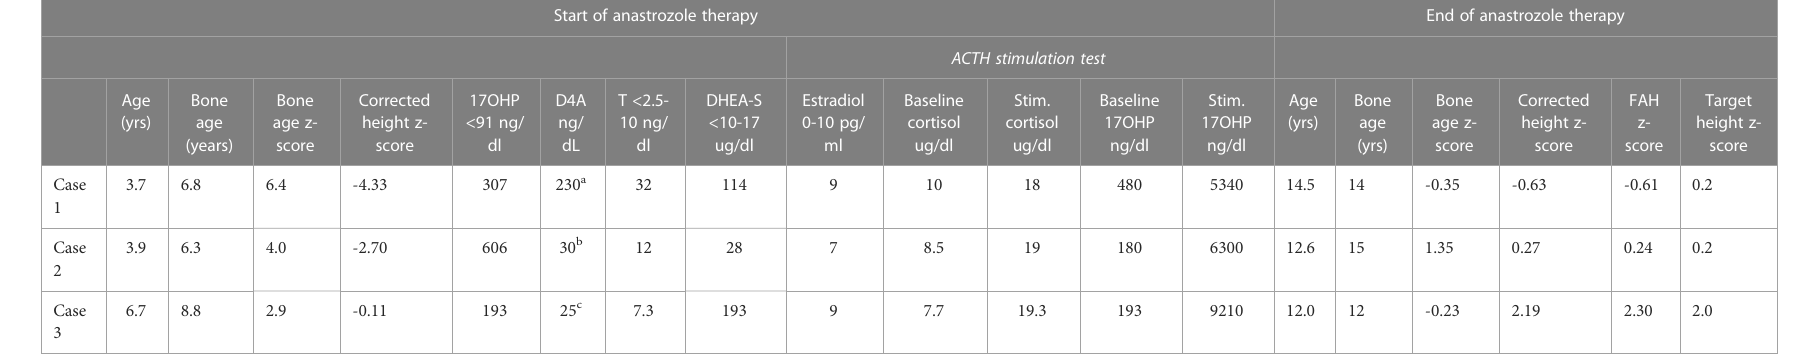
TABLE 1 Bone age z-scores, height z-scores, and hormonal levels at the initiation and end of anastrozole therapy. Start of anastrozole therapy End of anastrozole therapy ACTH stimulation test Age